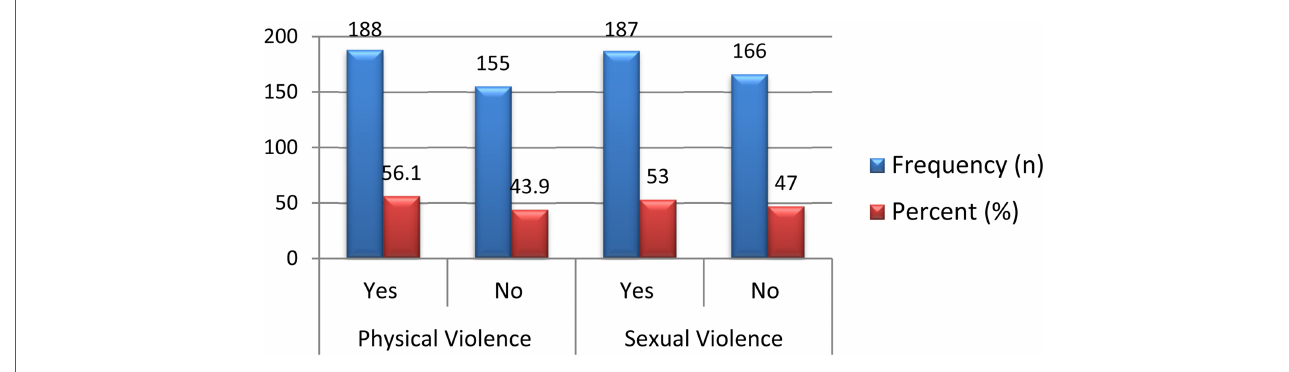
FIGURE 1 Prevalence of physical and sexual violence among female university students in their life time, southwest Ethiopia, 2021.